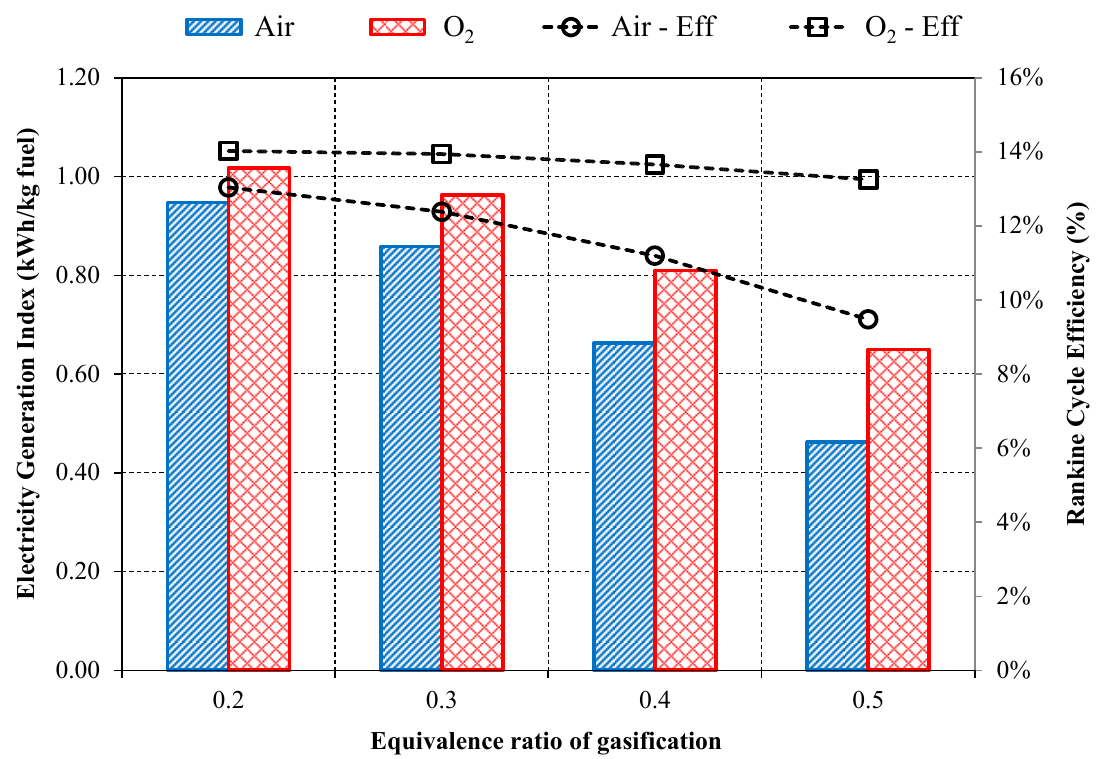
Figure 10. Electricity generation index from producer gas use in Rankine cycle.